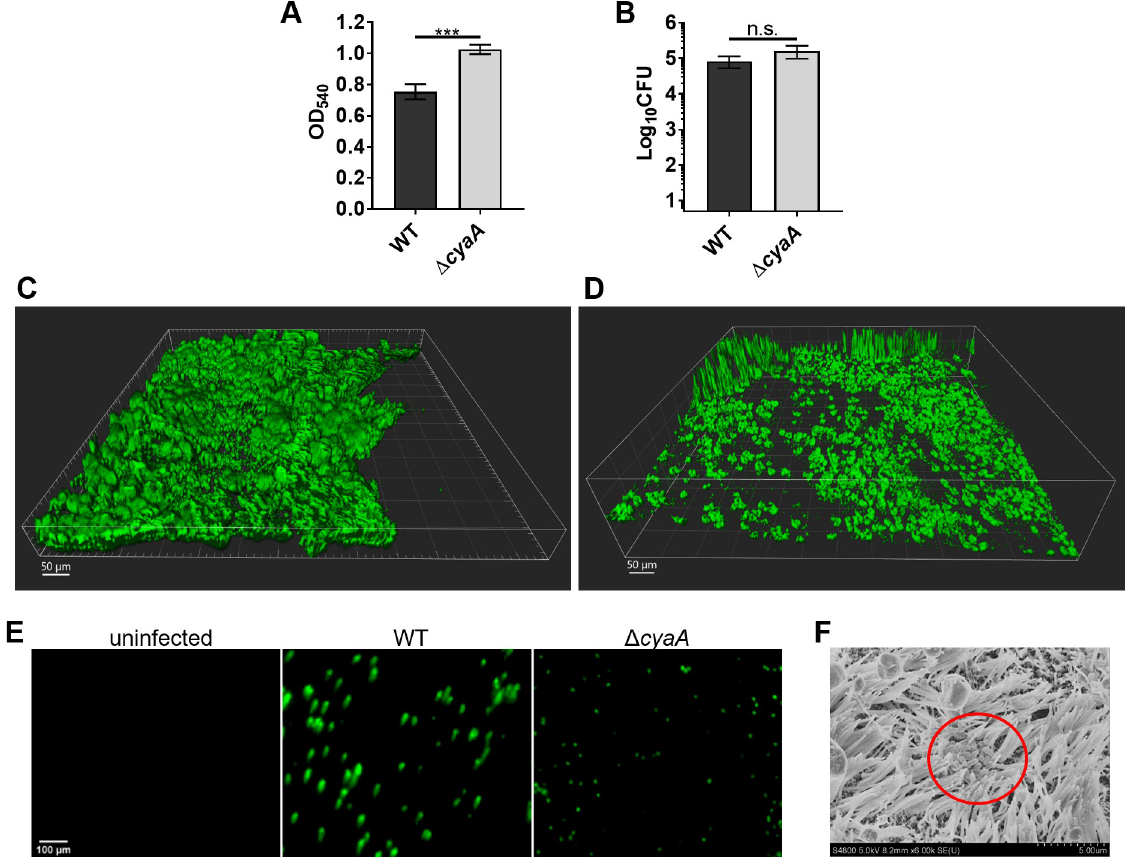
Fig 5. The role of adenylate cyclase toxin in Bp biofilm formation on HBE cells. (A) Biofilm formation after 96 h was evaluated by GFP- labeled bacteria in microtiter plates by crystal violet method. Bars indicate the mean and standard error of the mean of two independent experiments performed by triplicate. Significant differences were calculated by using one-way ANOVA and Bonferroni post hoc. ��� , p < 0.0005. (B-E) HBE cells were apically infected with bacterial strains in DMEM for 1 h at MOI 10. (B) CFUs were enumerated after 24 h on BG agar. Mean and standard error of the mean of two biological replicates in technical duplicate are presented. Statistical differences were assessed by unpaired Student’s t -test. n.s., not significant. (C-D) HBE cells infected with GFP-expressing WT (C) or Δ cyaA (D) strains for 48 h were fixed and imaged using an Olympus FV3000 confocal microscope (20X objective). Z-stacks were acquired at 1- μ m intervals. IMARIS software was used to produce a shading picture of the biofilms. (E) Representative live cell images of GFP-labeled bacteria on apical surface of HBE cells after 48 h (10X objective). (F) Scanning electron microscopy of bacterial strains 24 h after infection of HBE cells. For C-F, images are representative of at least two biological